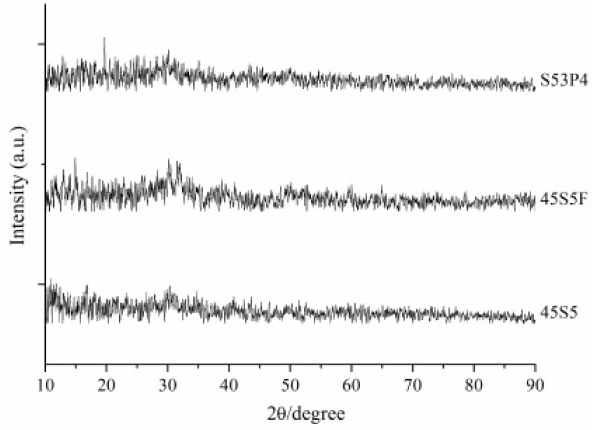
Figure 3. The XRD patterns for three different types of